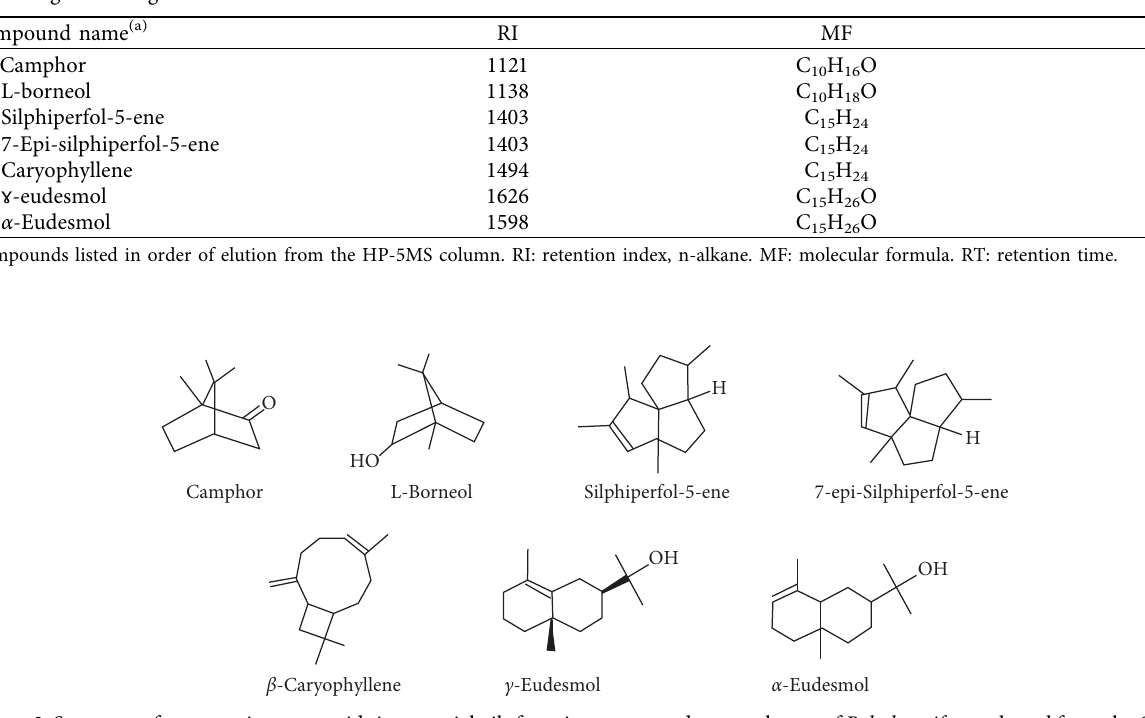
Table 2: Details of seven major terpenoids in essential oils from immature and mature leaves of B. balsamifera , selected from the GC-MS chromatogram of Figures S6-S7.